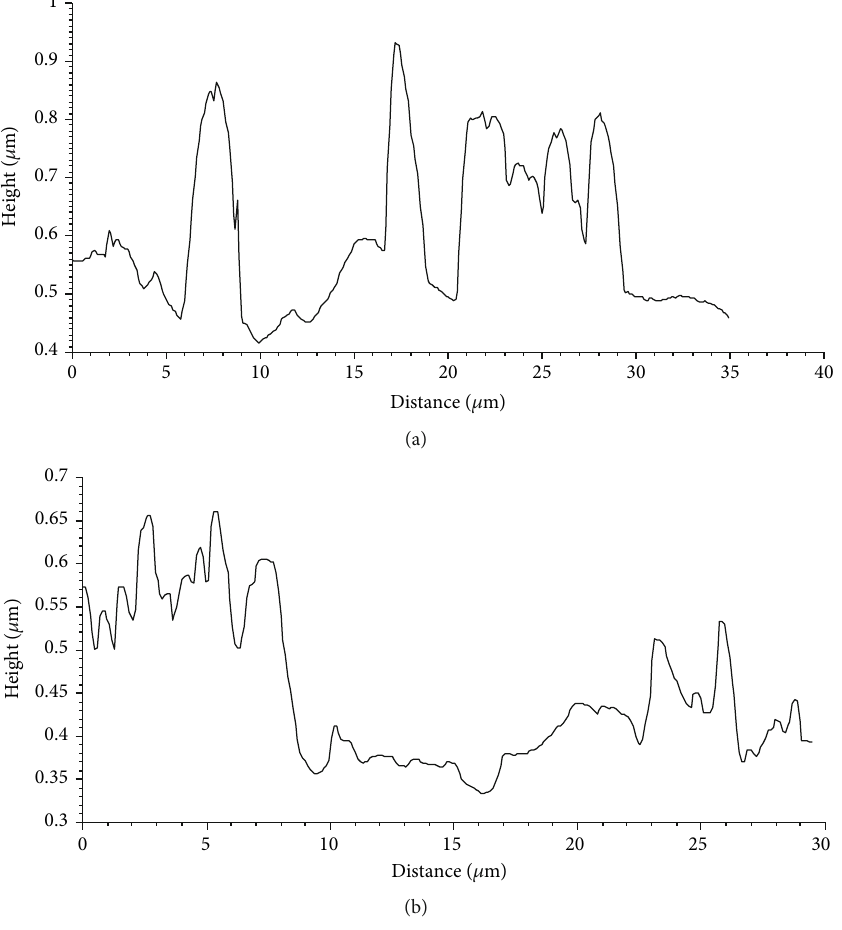
Figure 4: Pro fi les of the CNC samples. (a) CNC fi lm and (b) CNC fi lm formed with a 5 wt% CNC suspension. Table 2: Dielectric properties of cellulosic samples at 25 ° C.